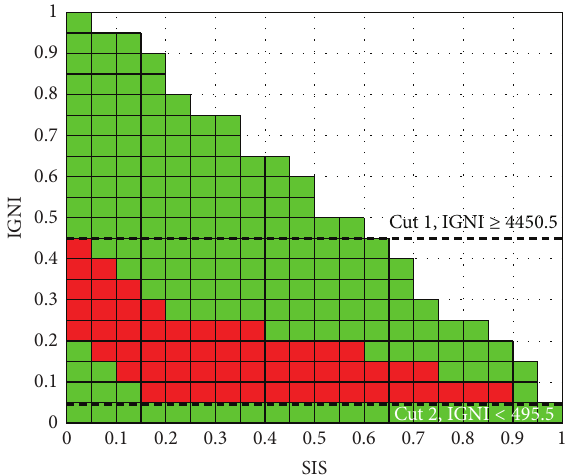
Figure 5: Cluster representation of the failure domain (red) and safety domain (green) for the sequence [ INI SIS IGNI ] , axes scaled between 0 and 1.